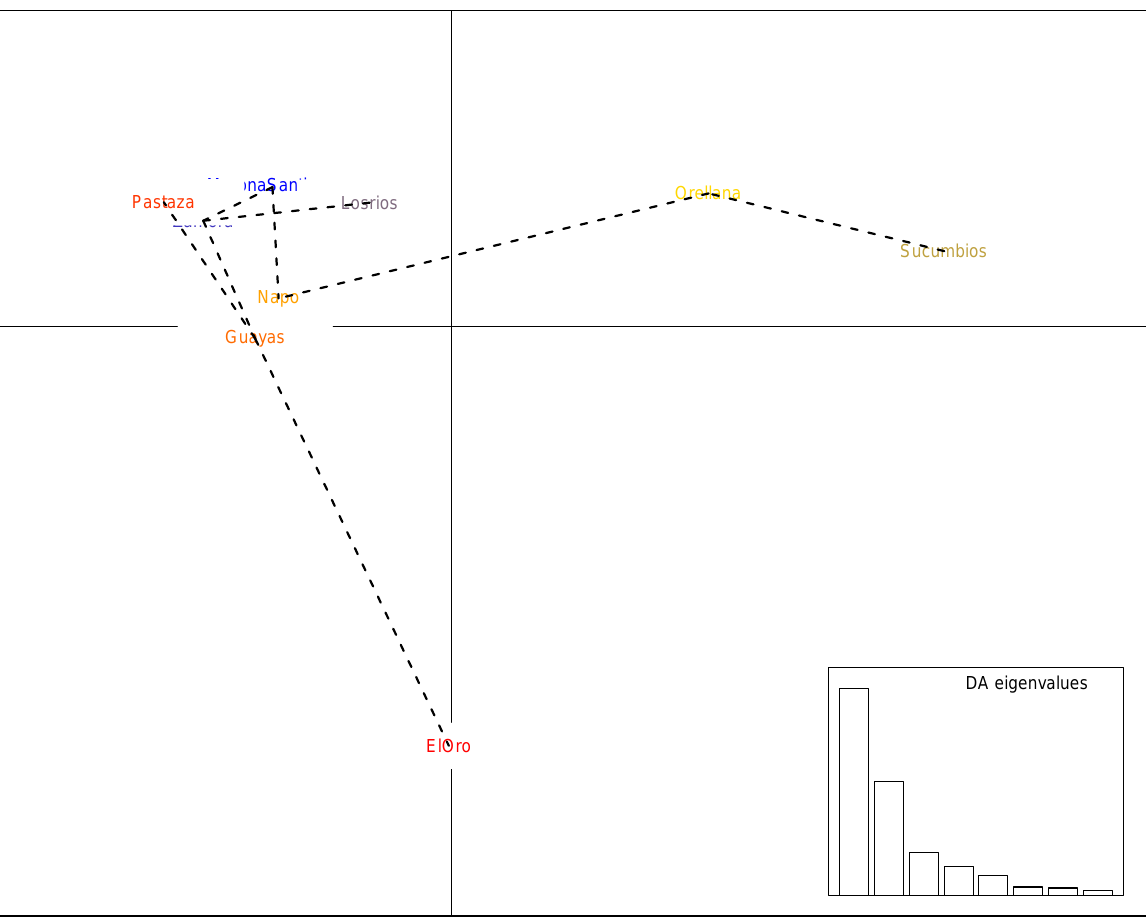
Figure 5. Biplot of discriminant analysis of principal components (DAPC) for 76 isolates of M. roreri collected in Ecuador’s Amazon and coastal regions in 2019. The axes represent the first two Linear Discriminants (see histogram). Color represents provinces, and each dot represents an individual. The representation of the MSN shows that the Amazonian isolates are more connected than the Pacific coast isolates, forming a cohesive group. At the same time, the isolates from the Pacific coast appear mostly towards the periphery (magenta circles). The Pacific coast isolates are distributed in four different places of the network (Figure 6), indicating different lineages. Surprisingly, isolates of Guayas province are found in three of the different lineages. These patterns added to the lower genetic diversity of the Pacific coast (Figure 5) show that the populations of the Pacific coast are derived from at least three or four independent introductions from the